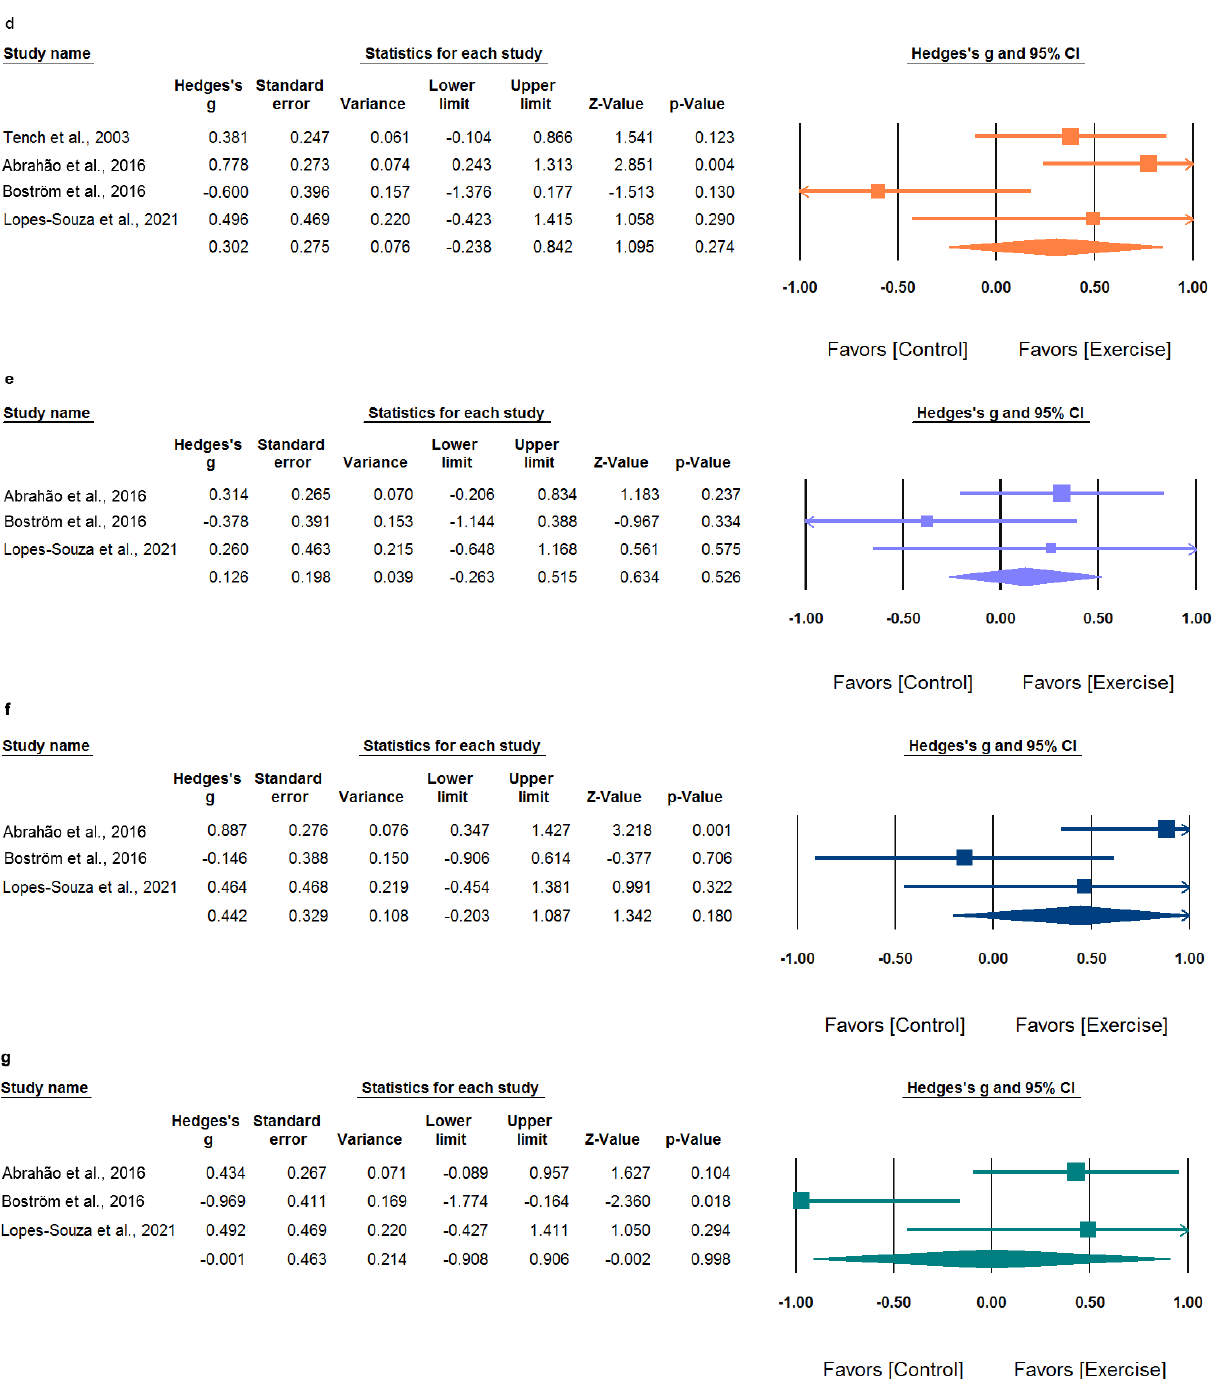
Figure 5. Forest plot of comparison with the outcome of the SF-36 domains other than the physical function domain: ( a ) role physical, ( b ) pain, ( c ) general health, ( d ) vitality, ( e ) social functioning, ( f ) role emotional, and ( g ) mental health.